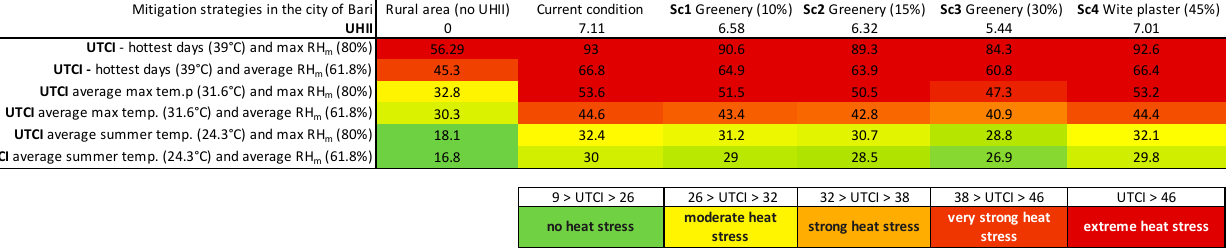
Figure 9. Universal Thermal Climate Index (UTCI); heat stress in different scenarios and meteorological conditions.